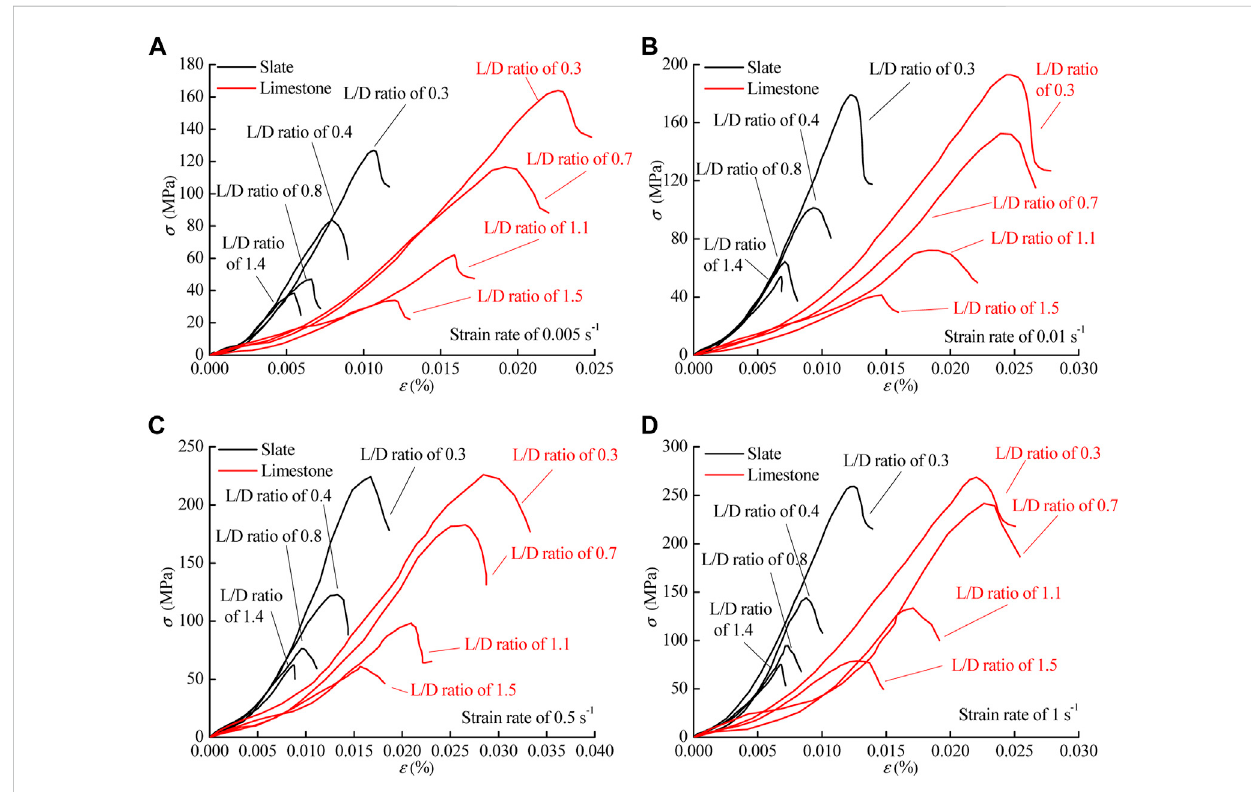
FIGURE 4 Stress – strain curve of slate and limestone under different loading rates. (A) 0.005s − 1 , (B) 0.01s − 1 , (C) 0.5s − 1 , and (D) 1s − 1